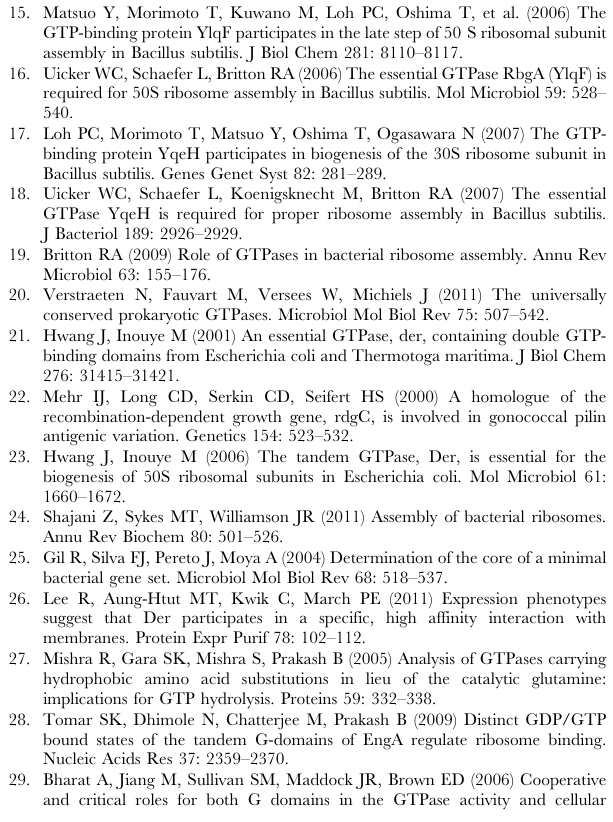
Table S1 Fitted Kinetic parameters of B. subtilis EngA obtained from Fig. 2. Table S2 Effect of K + on the affinity of EngA for different nucleotides. nd : not determined. Table S3 Tm values obtained from the thermal shift experiments shown in Fig. 5. Table S4 Crystallographic data collection and refine- ment statistics for EngA structures in the presence of different ligands. a Values in parentheses refer to the